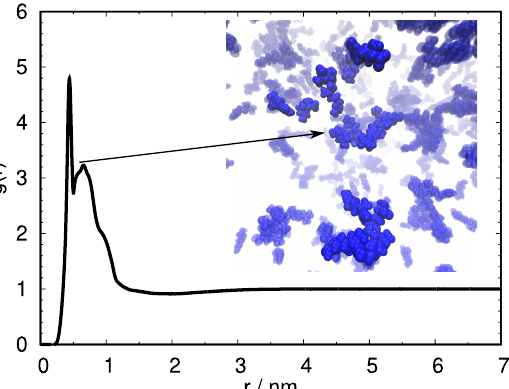
Figure 2. Arginine–arginine COM pair distribution function with a snapshot of arginine clustering from the simulated 0.3 M arginine solution at 267 K.